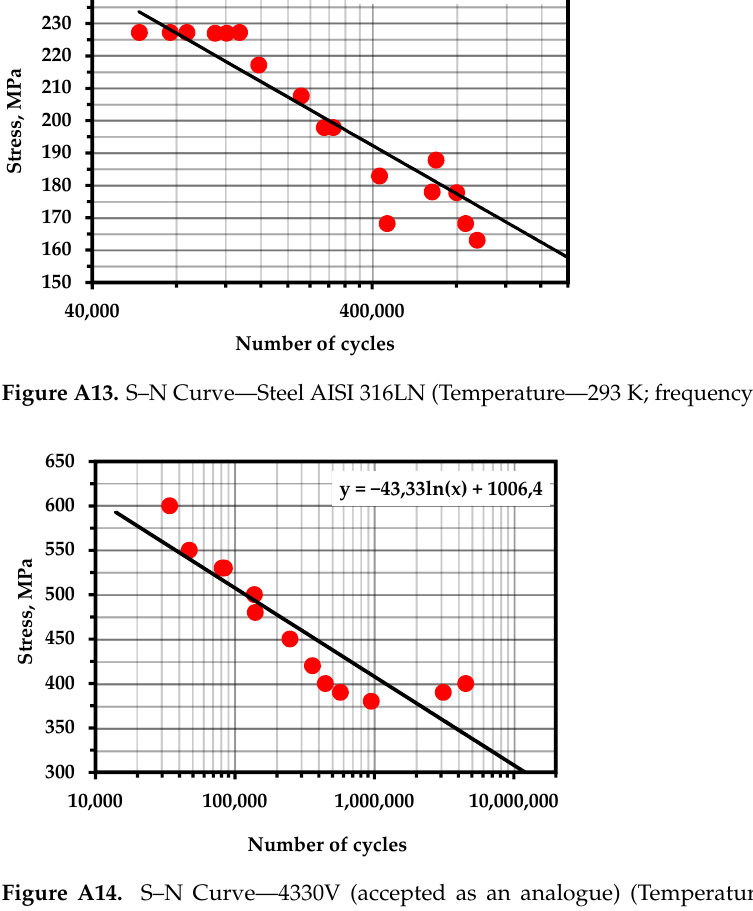
Figure A14. S–N Curve—4330V (accepted as an analogue) (Temperature—293 К ; frequency—50 Hz) [107].